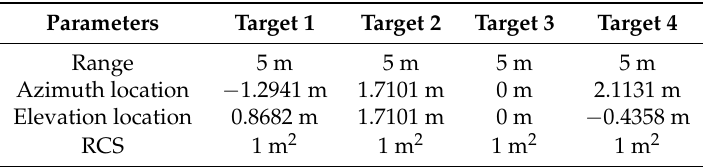
Table 2. Four targets’ scheme setup. RCS, radar